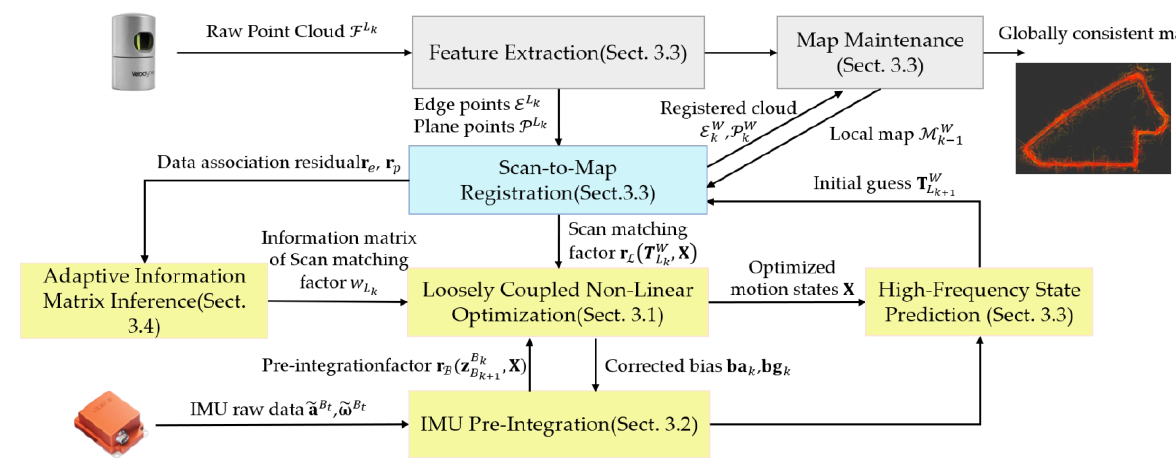
Figure 1. Flowchart of the proposed coarse-to-fine loosely coupled LiDAR-inertial odometry. The yellow boxes represent the coarse process via the LC optimization. The blue box represents the fine process via the scan-to-map registration. The LC optimization provides an initial guess for the scan-to-map registration of the next frame.